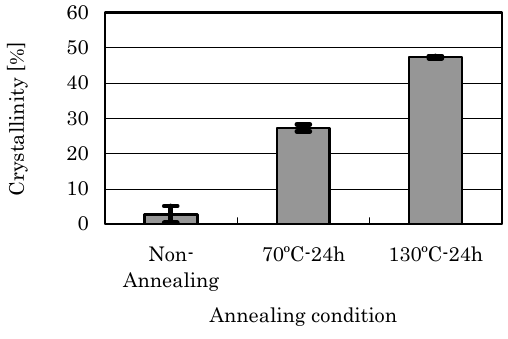
Figure 1 Crystallinity of PLLA with annealing